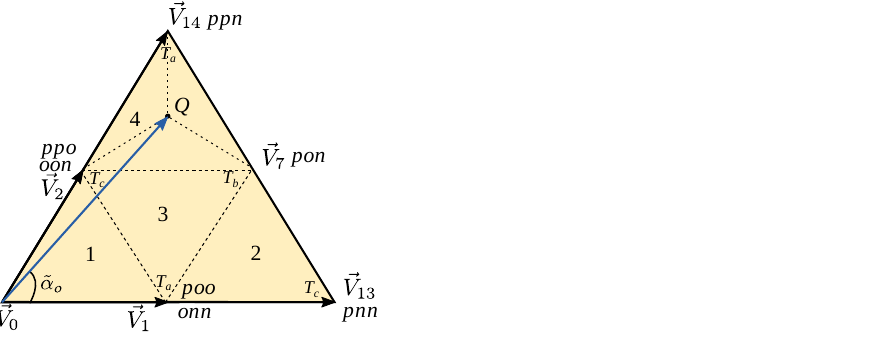
Figure 10. Example to demonstrate the relationship between (cid:126) V ref and the times of each